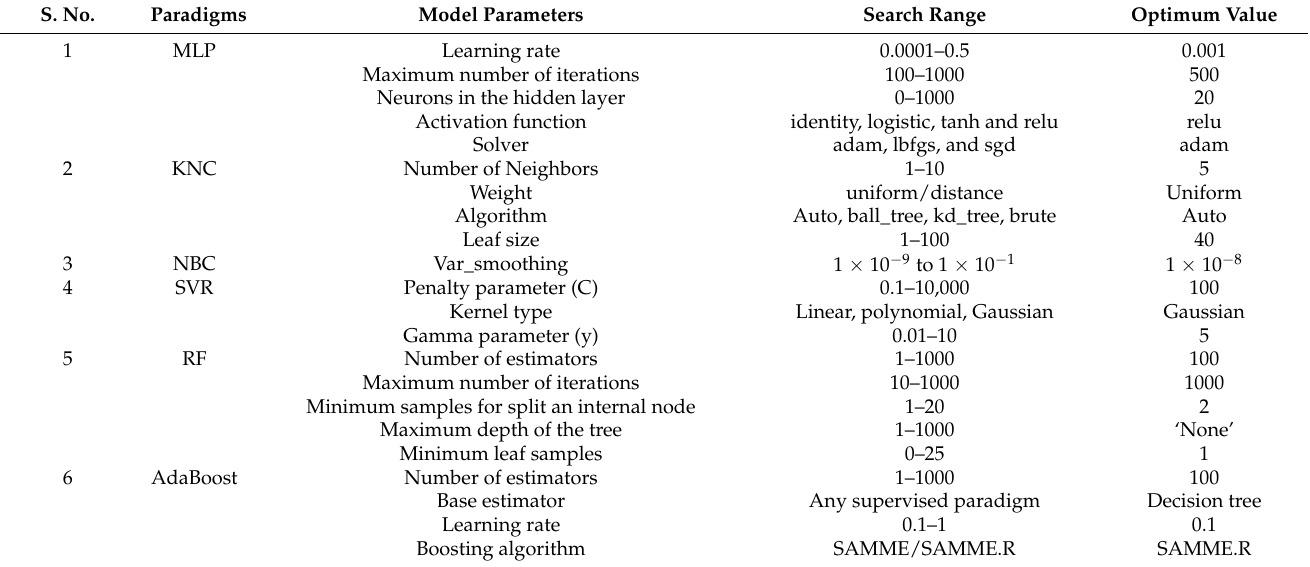
Figure 10. Validation curves generated for four important parameters of RF ( a ) Number of estimators ( b ) Maximum depth of decision tree ( c ) Minimum samples needed at leaf node ( d ) Minimum number of samples needed for splitting. Table 4. Optimum values of various models’ parameters applied in this research